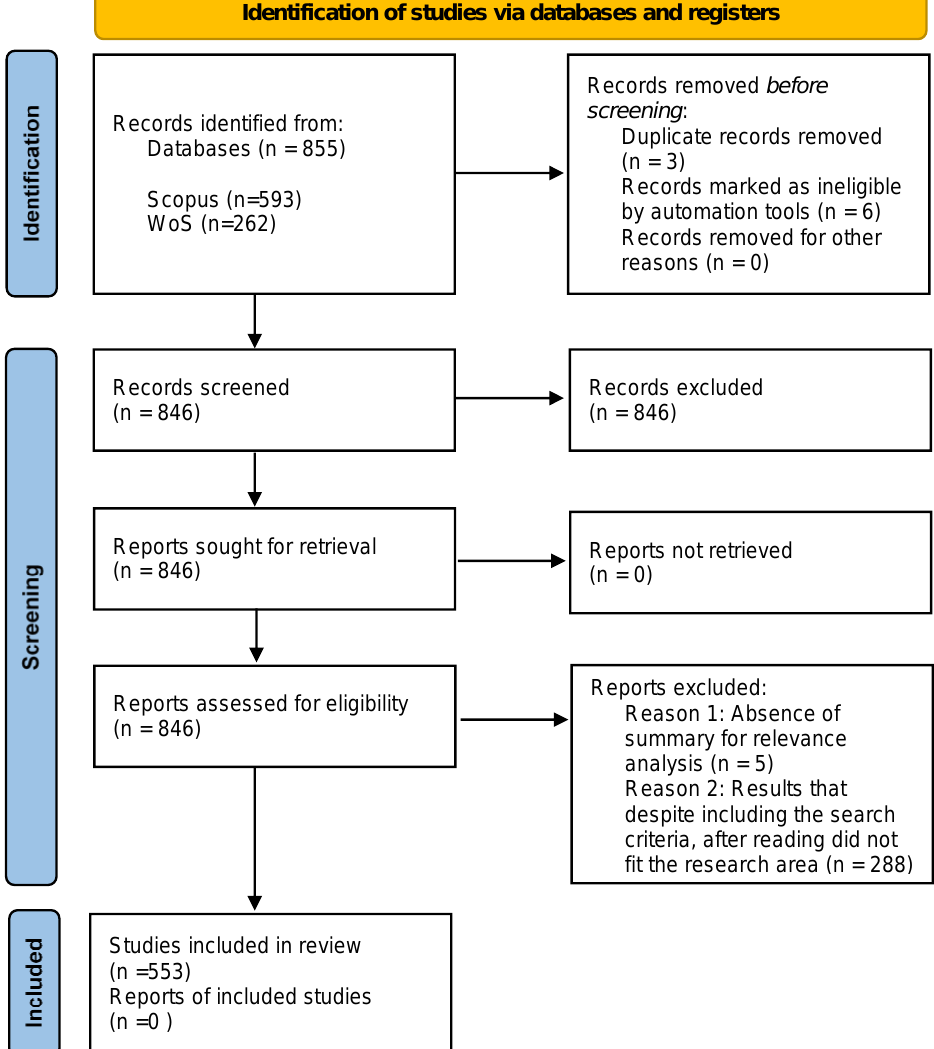
Figure 1. PRISMA method procedure that details the steps in the identification and selection of documentary units. Note: PRISMA 2020 flowchart. The new design has been adapted from the flowcharts proposed by Boers [60], Mayo – Wilson et al. [61], and Stovold et al. [62].